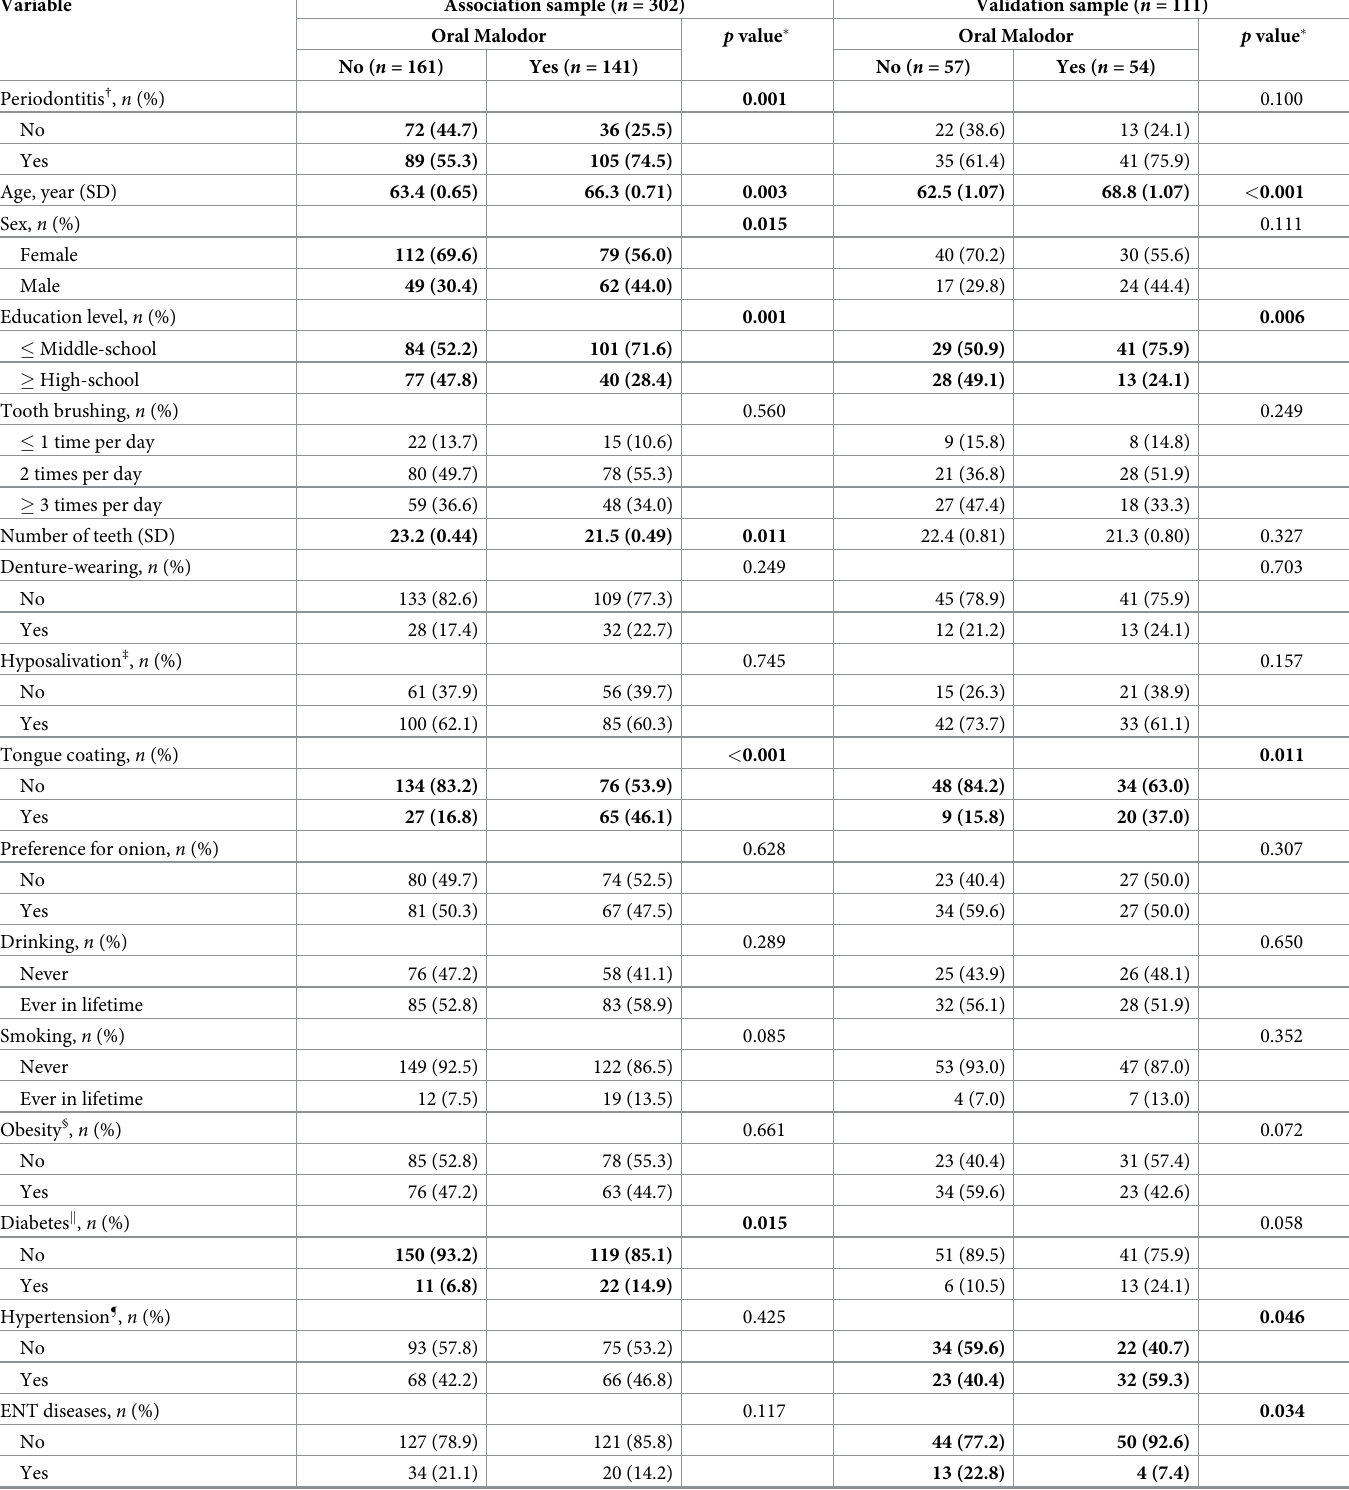
Table 1. Characteristics of the subjects by oral malodor (OLS � 2) in the association and validation